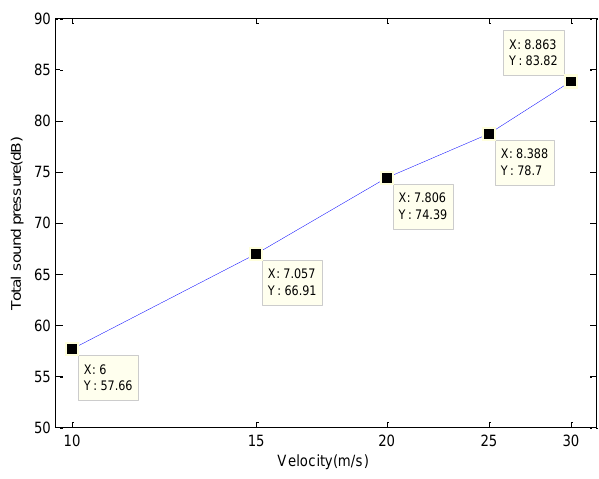
Figure 6. Variation of total sound level with speed.